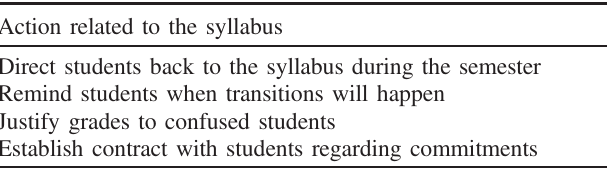
TABLE XI. Additional syllabus-related actions pointed out by the expert instructors ( N ¼ 8